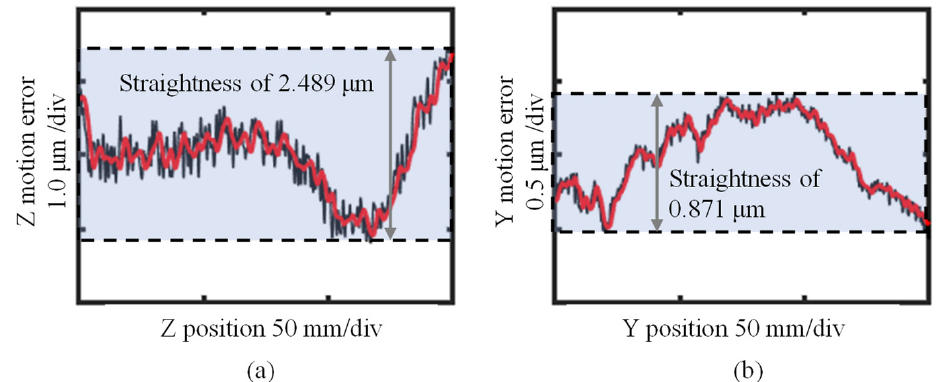
Figure 15. Experimental results of the calibration of the Y / Z -slide motion error. ( a ) Calibration of the Z -slide motion error; ( b ) calibration of the Y -slide motion error.